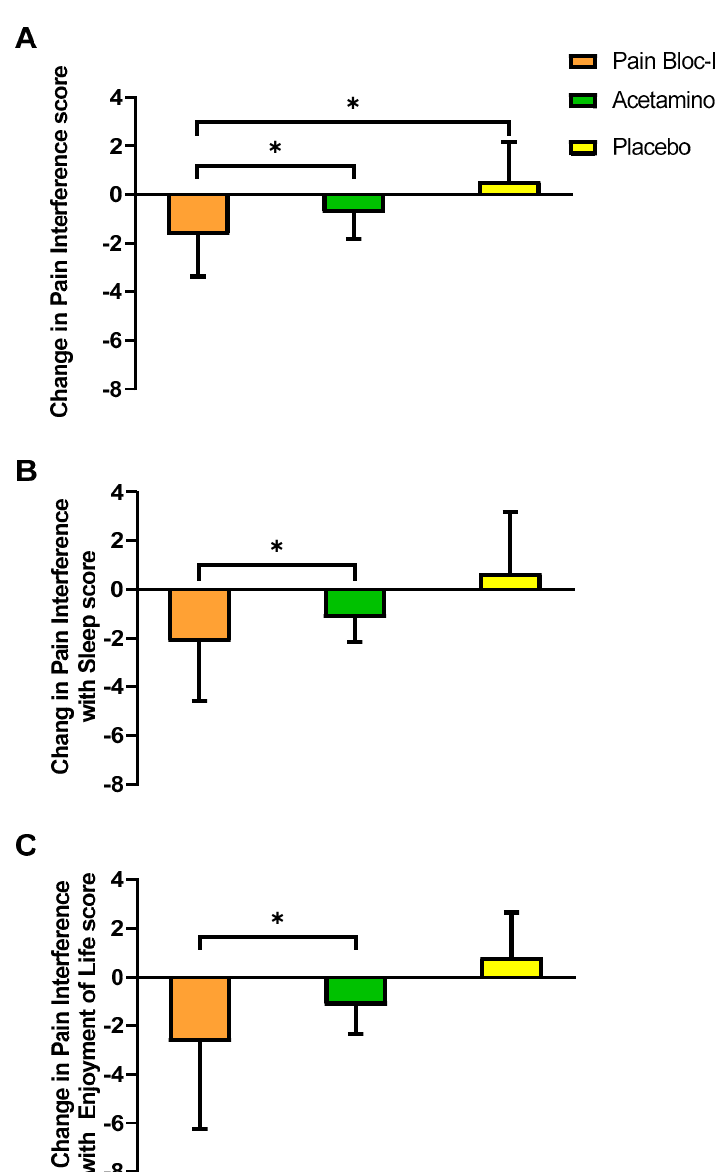
Figure 5. Change in ( A ) pain interference score, ( B ) pain interference with sleep score, ( C ) pain interference with enjoyment of life score from pre-supplementation to post-supplementation (day 7) in the ≤ 45 years of age male PP population ( n = 6). n, number; SD, standard deviation. Between group p -values were generated using a linear mixed effect model with treatment, sequence, and period as fixed effects and subject as a random effect. Between group p -values were adjusted using Tukey’s HSD. * p ≤ 0.05 considered statistically significant.